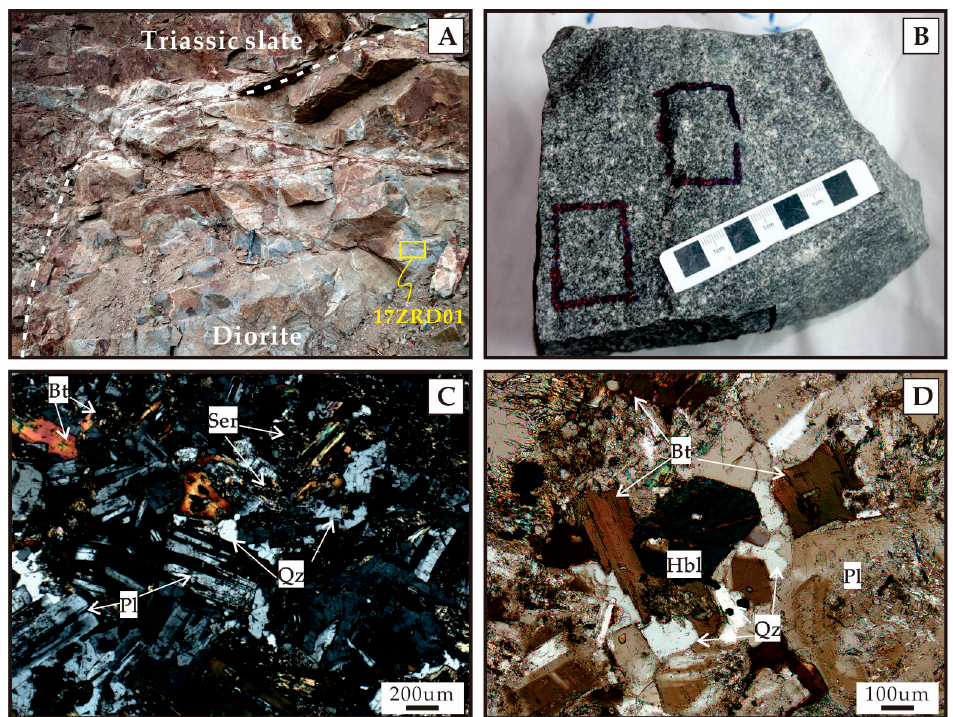
Figure 4. Photographs and photomicrographs of the diorite in the Zaorendao deposit showing its geologic relationship with Triassic slate ( A ) and texture and mineral association ( B – D ). Blue box lines in Figure B show locations of doubly polished thin sections. Mineral abbreviations: Bt = biotite, Hbl = hornblende, Pl = plagioclase, Qz = quartz, Ser = sericite.